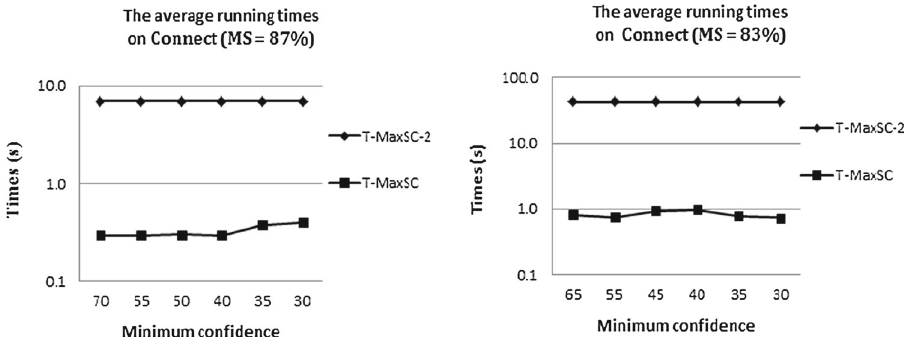
Fig. 9 Average running